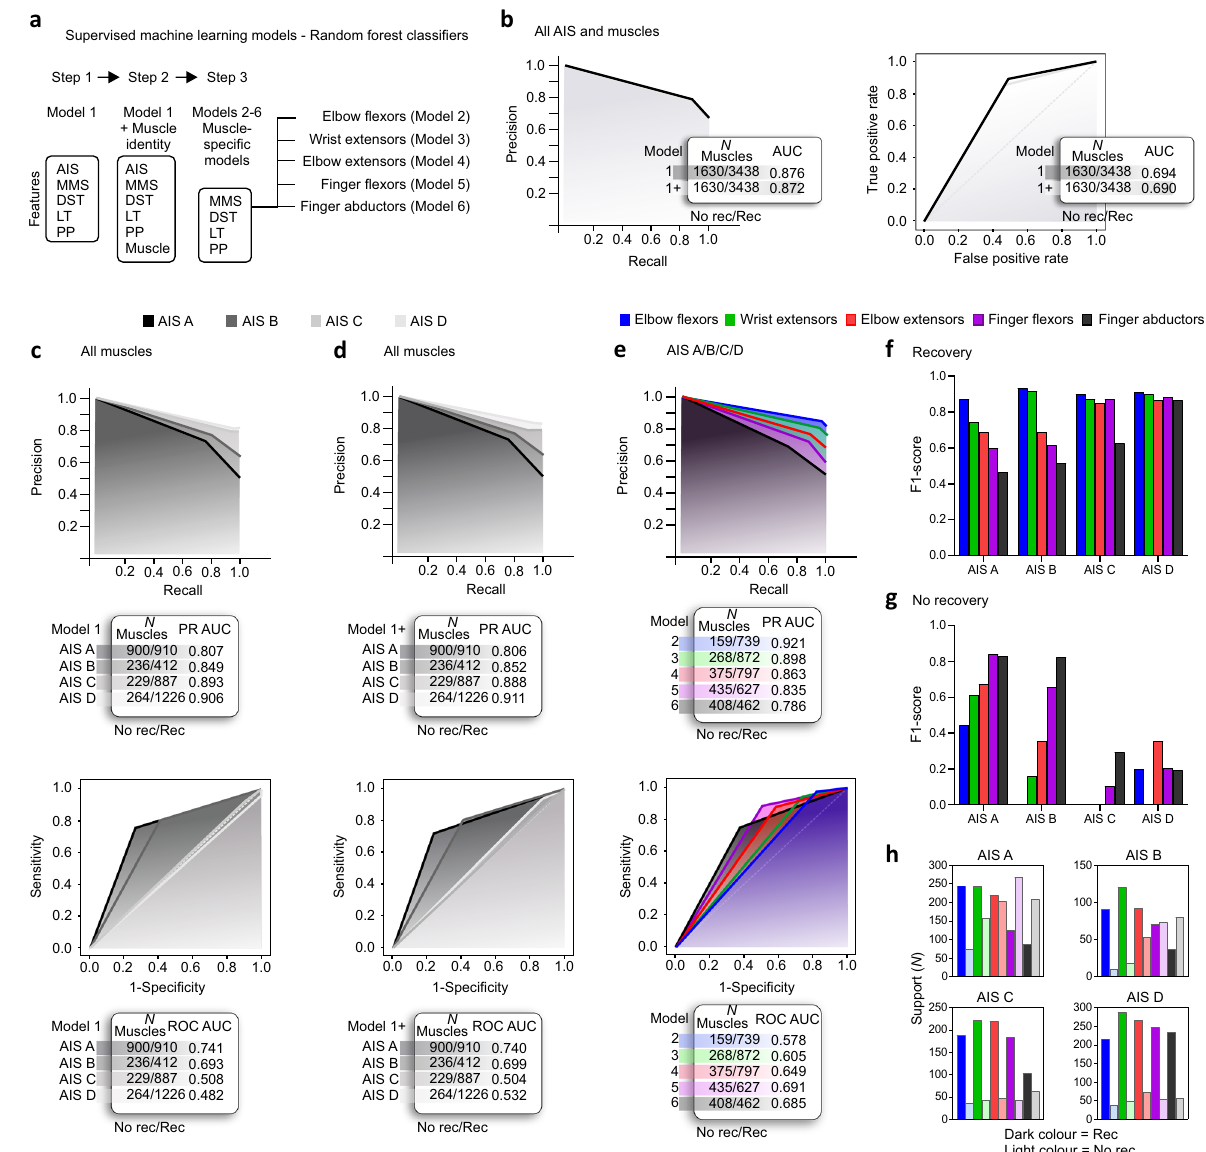
Fig. 5 | Prediction ofstrength recovery aftercervicalSCI: the role ofadditional muscle-speci fi cfeatures. Thepredictionofstrengthrecoverydisplaysaproximal- to-distal gradient in individuals with a sensorimotor complete lesion, where the strength recovery of distal hand muscles is hard to predict. a Supervised machine learning models: a three steps approach is utilized to understand the predictive factors for segmental strength recovery after cervical SCI. b We corroborate the importanceofAISandMMSinpredictingrecoveryafterSCIwithaPRAUCof ≈ 0.87 and ROC AUC ≈ 0.69 (see Supplementary Table 3 for feature importance in each model). c AIS-speci fi c models indicate it is harder to predict strength recovery in AIS A/B, compared to AIS C/D. d The addition of muscle identity as a feature does not increase the prediction performance of the AIS-speci fi c models. e Muscle- speci fi c modelsindicate a proximalto distalgradient, wherethe strength recovery of distal hand muscles is harder to predict compared to the proximal muscles. f In individuals classi fi ed as AIS A, the prediction of strength recovery displays a good performance for elbow fl exors, a moderate performance is evident for wrist and